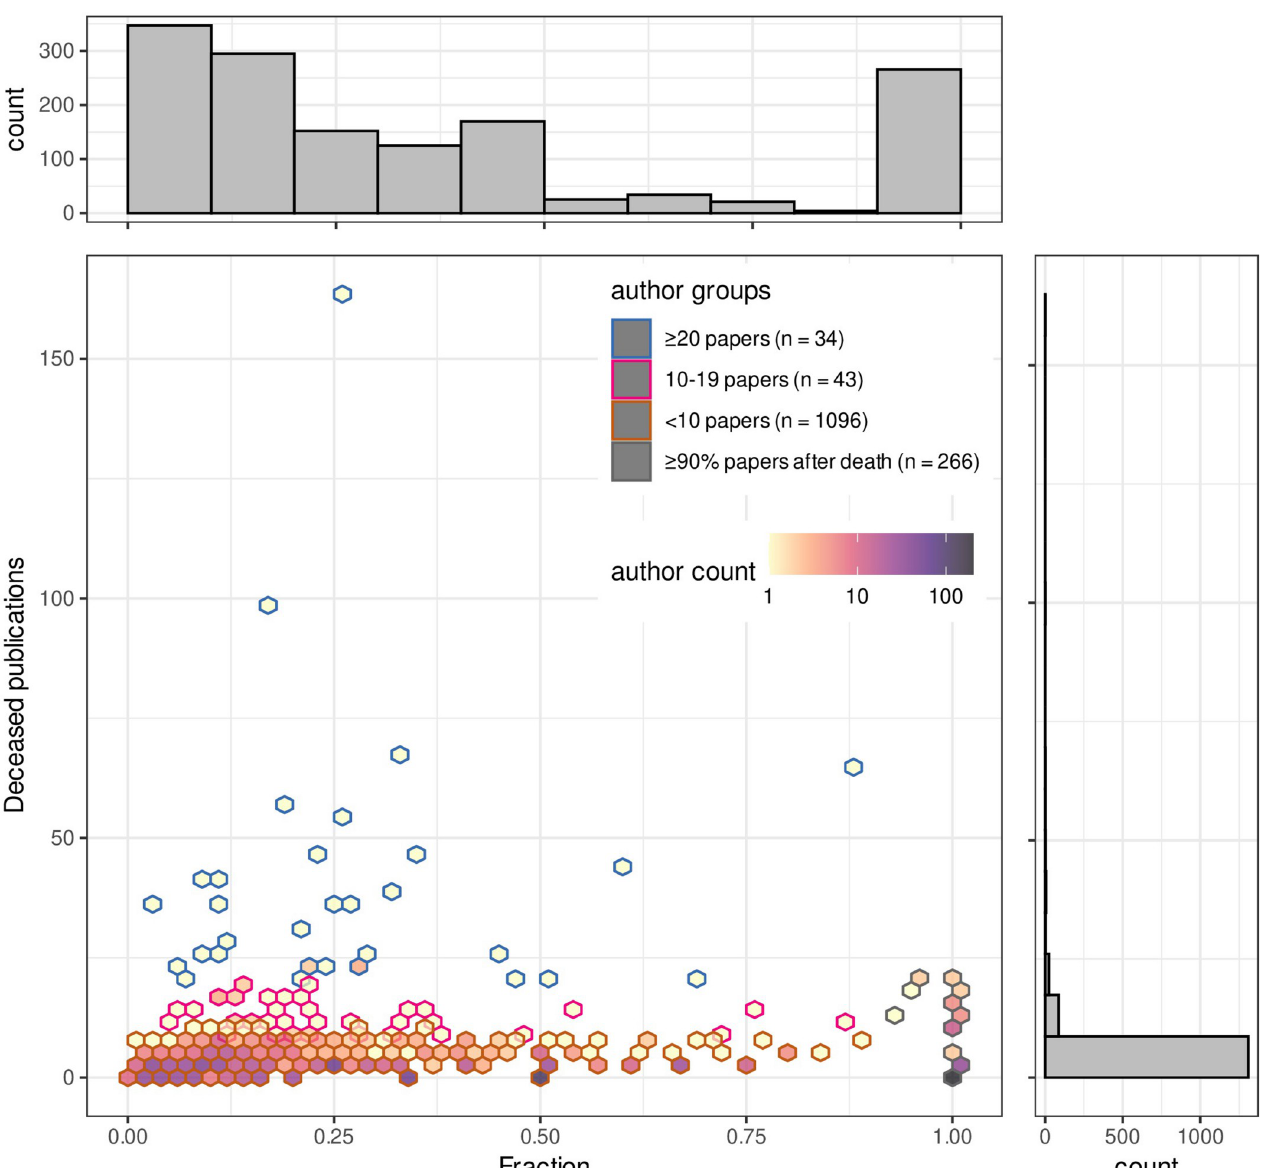
Fig 3. Fraction and the raw number of publications after death. Each hex bin dot represents a deceased author. The fraction of their deceased-publications compared to their total publications are on the X-axis and the raw number of their deceased-publications on the Y-axis. The fraction of deceased-publications was calculated from the total publications published by deceased authors over their careers. Authors were grouped into four based on the number of publications after death and the fraction of deceased-publications over the career. Either; authors with 20 or more deceased-publication; authors with 10 to 19 deceased-publications; authors with less than 10 deceased-publications, or authors who published 90% or more of the total publication as deceased- publications regardless of the number of deceased-publications. Histogram plots represent the actual number of either the fraction of deceased publications (top) or number of deceased publications (side). Hex bin dot colors refer to numbers of deceased authors across a continuous range as